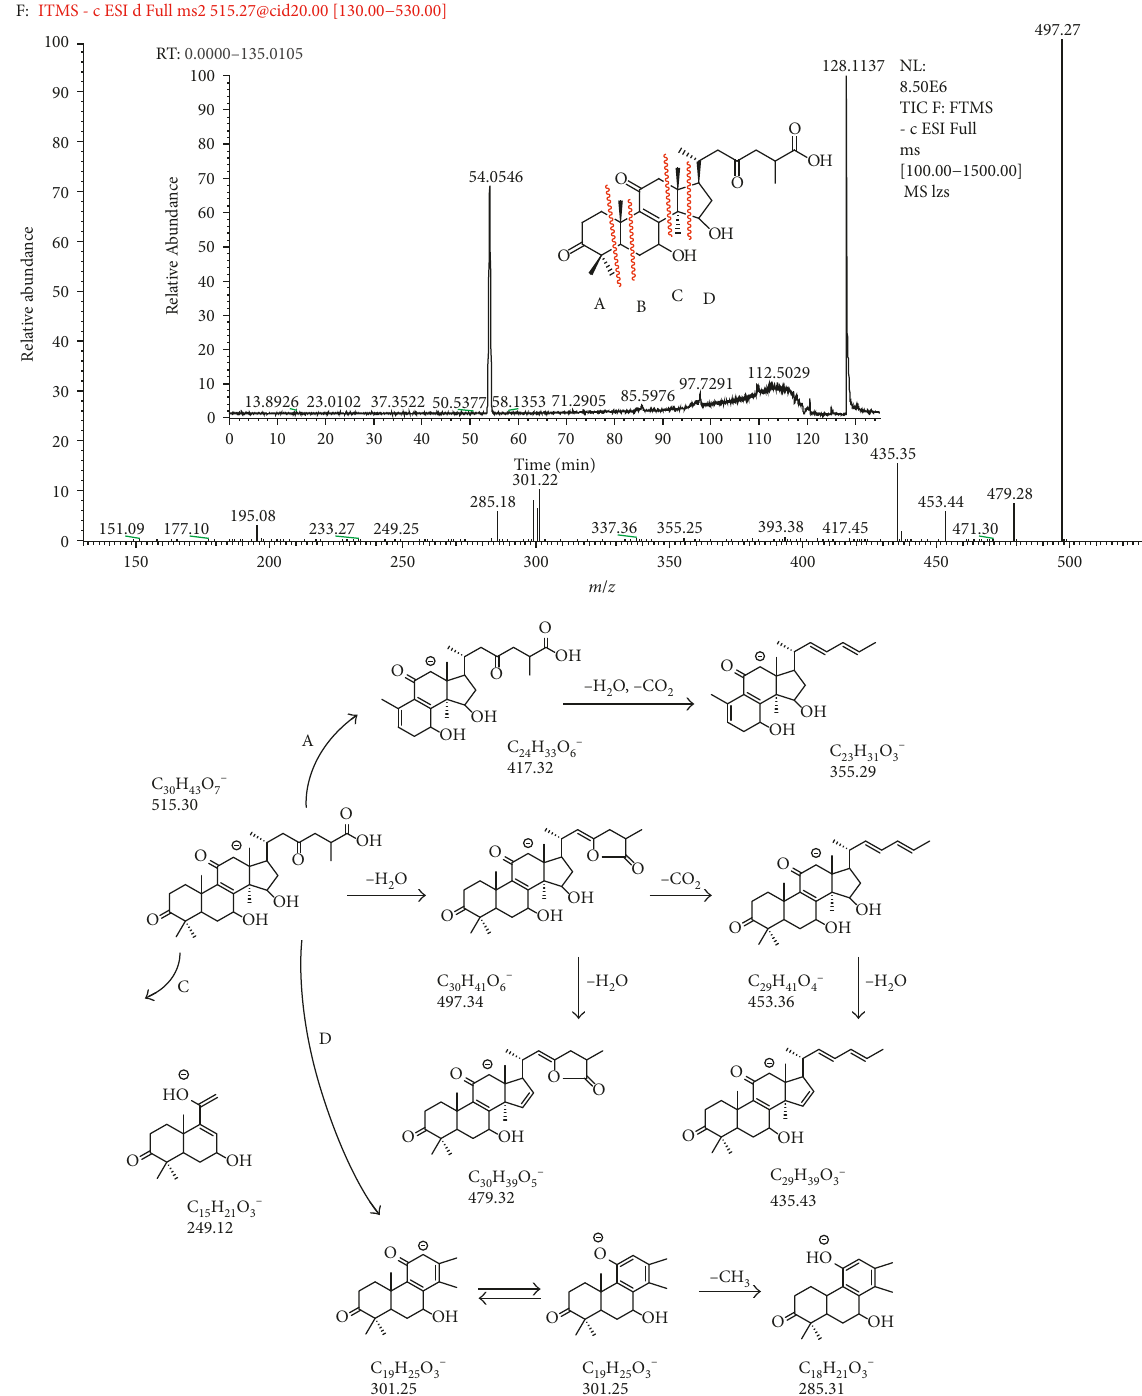
Figure 4: The mass spectrum and cleavage pathway of ganoderic acid